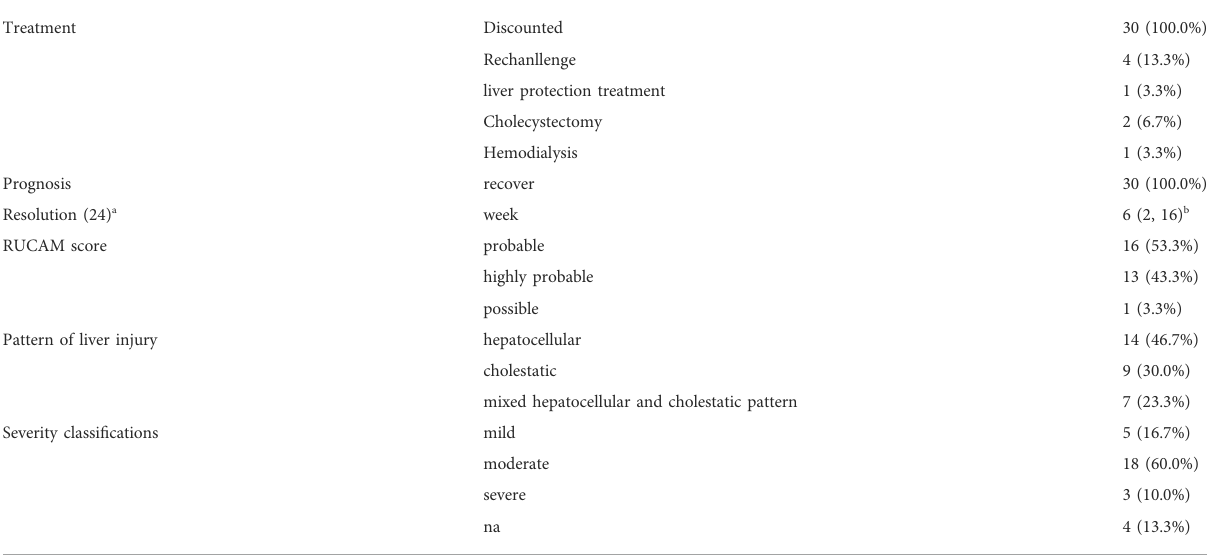
TABLE 4 Treatment and prognosis of 30 cases of metformin-induced hepatotoxicity.